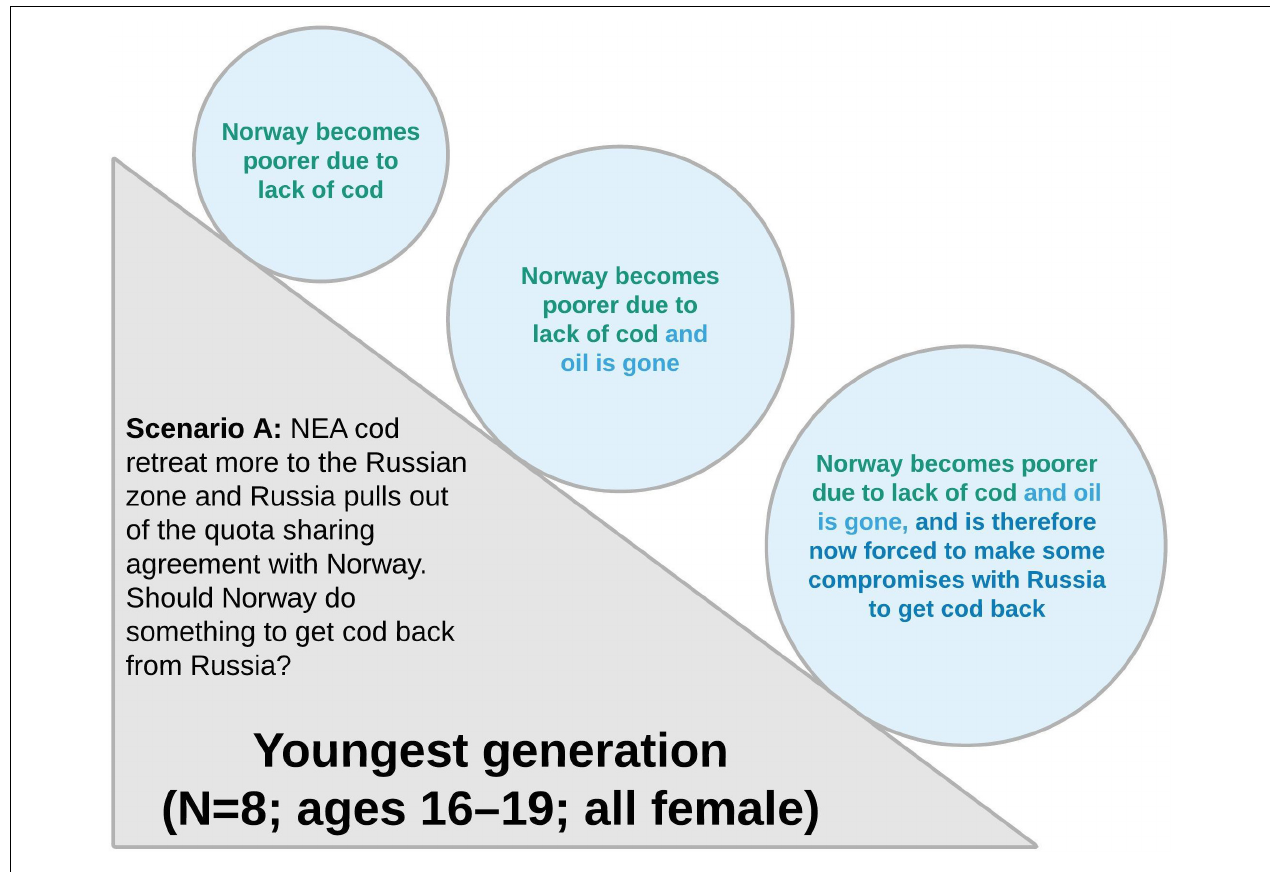
FIGURE 7 | A schematic summarizing the discussion among youths in Bergen, Norway in June 2019.